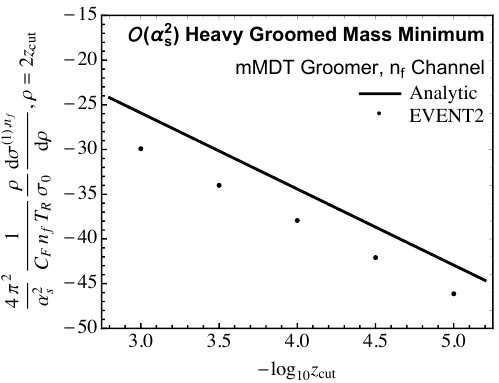
) contribution to the s